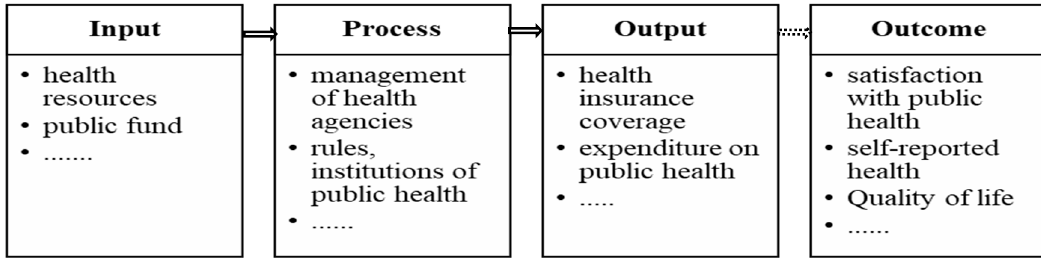
Figure 1. The Input-Process-Output-Outcome (IPOO) model for public health